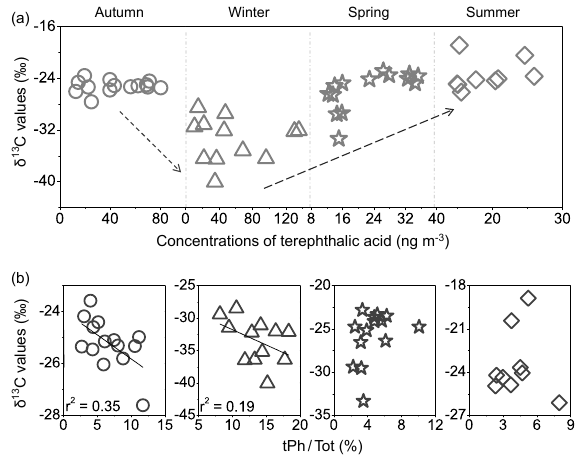
Figure 9. (a) Seasonal variations in δ 13 C of tPh; (b) correlations between the δ 13 C values of tPh and relative abundances of tereph- thalic acid to total diacids (tPh / Tot) in PM 2 . 5 in